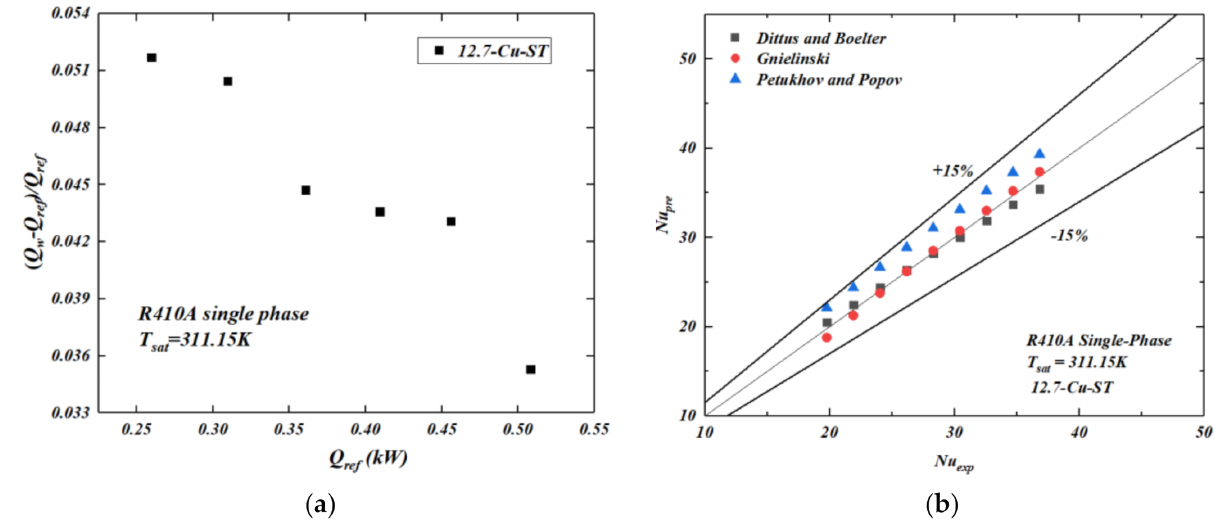
Figure 5. ( a ) Single-phase heat balance verification. ( b ) Comparison of current smooth tube experi- mental results with various